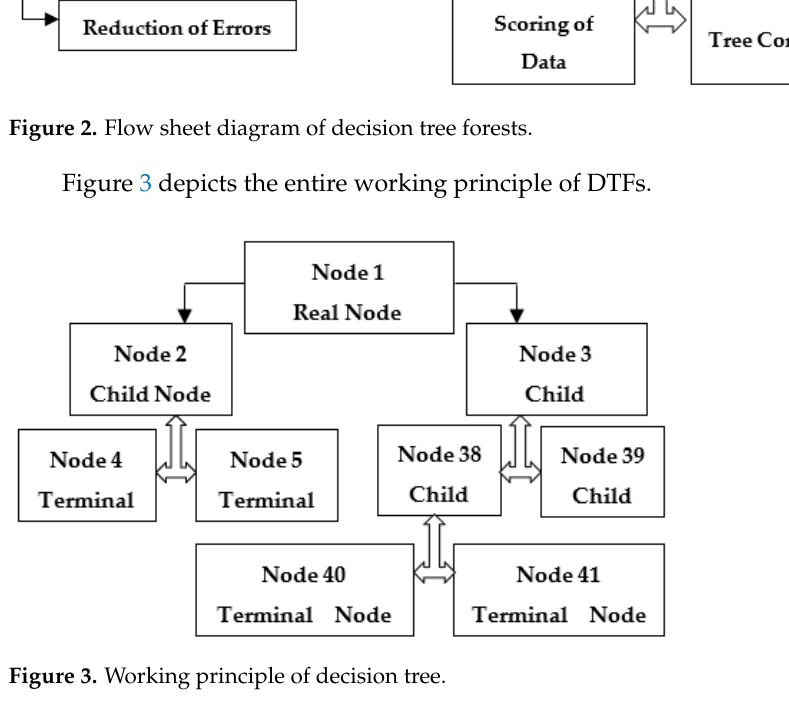
Figure 3. Working principle of decision tree.